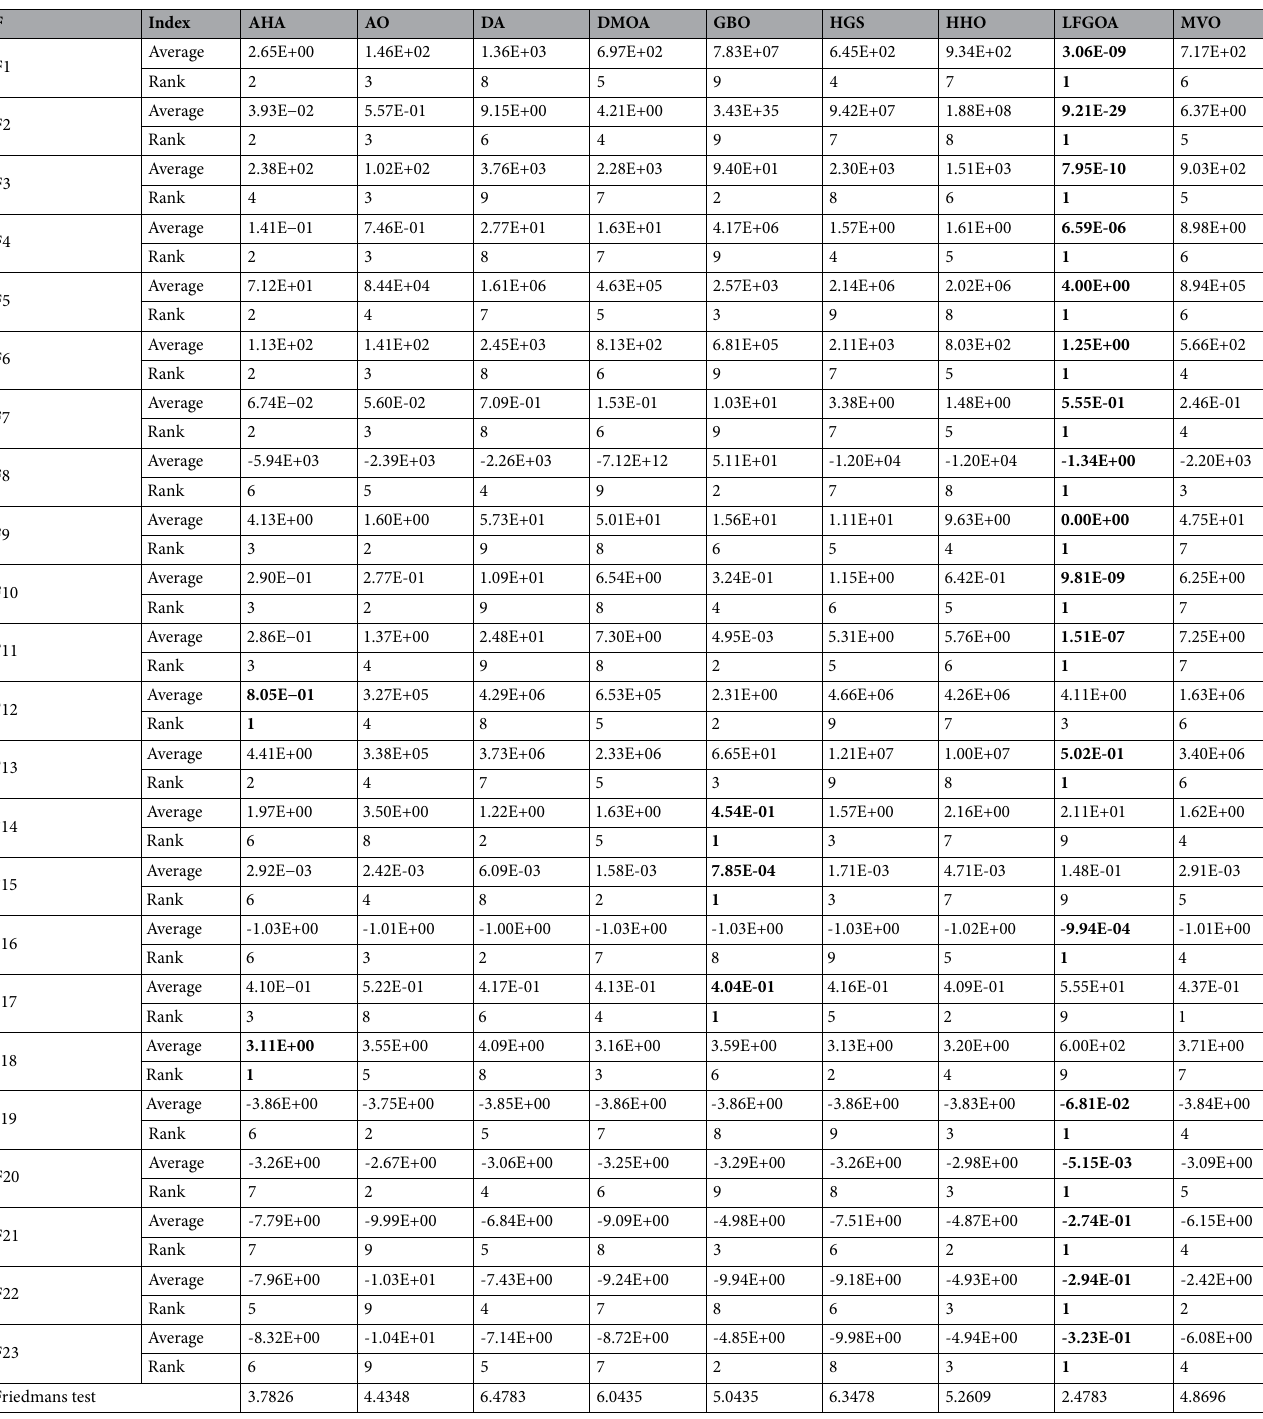
Table 3. The values of average and average Rank on nine algorithms. The best of the comparison results are in Fig. 3 shows the analysis results of the data from Table 7. In each line segments, we plot the average ranks about mean (left side in the Fig. 3) and Std (right side in the Fig. 3) of nine algorithms. The length of the line segment indicates the CD value, and the center of each line segment labeled “circle mark” represents the value of the average rank position about mean (left side) and Std (right side) of the respective each algorithm across all 23 benchmark test functions. If the value of the center between two line-segments (intervals) is greater than the CD, it means that the two algorithms do not overlap each other, which indicate there is a statistically significant difference between them.